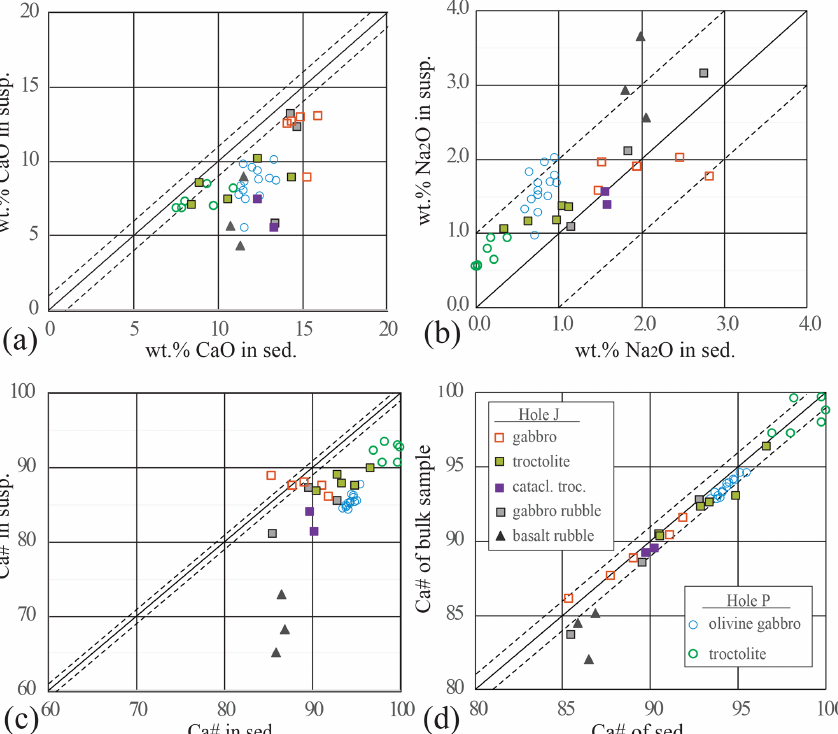
Figure 8. A comparison of the concentrations of CaO and Na 2 O in sedimented and suspended fractions of the channel samples. Solid line: 1 to 1, no fractionation. Dashed lines: ± 1% envelope. (a) The higher concentration of CaO in the sedimented subsample reflects the higher concentration of CaO in plagioclase, clinopyroxene, and prehnite. (b) Na 2 O is fractionated into the suspended subsample, reflecting its phyllosilicate host. (c) Graph showing the higher Ca# in the sedimented subsamples, consistent with the higher concentration of Ca in magmatic minerals. (d) A comparison of the Ca# in the sedimented subsample with the Ca# in the total sample. The similarity snows that the sedimented subsample dominates the Ca# in the total